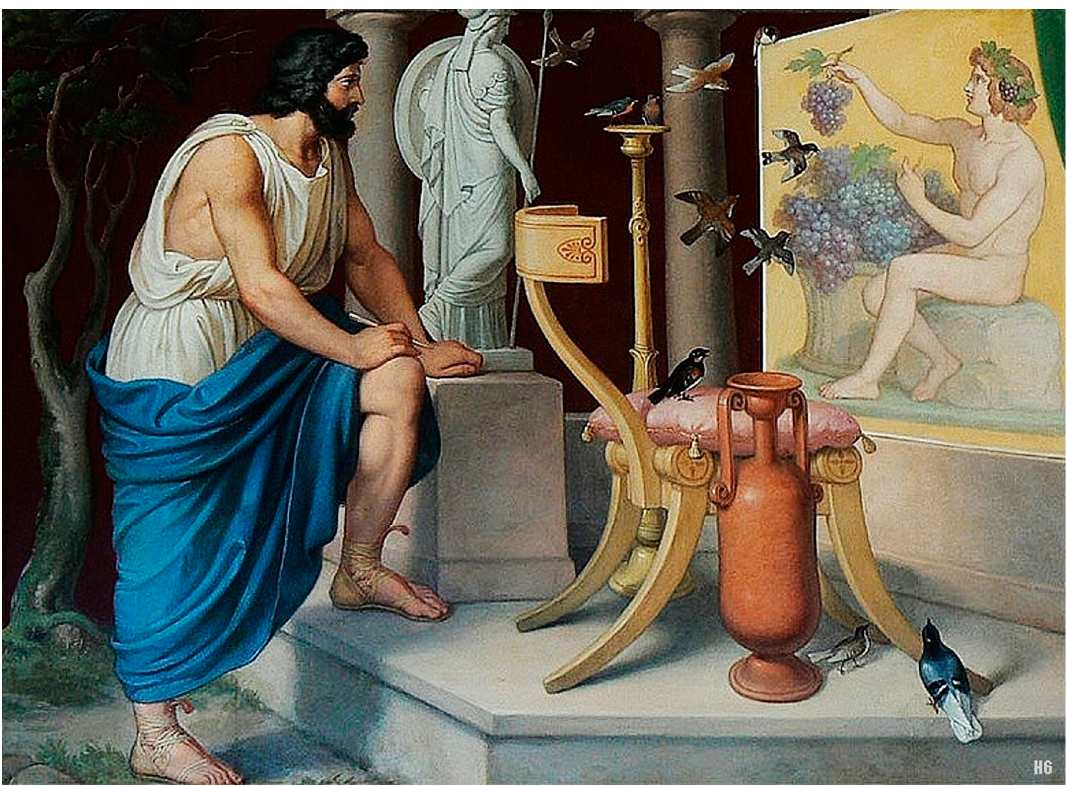
Figure 5. Johann Georg Hiltensperger, encaustic painting representing Zeuxis’ grape and the birds, Hermitage, Saint Petersburg,